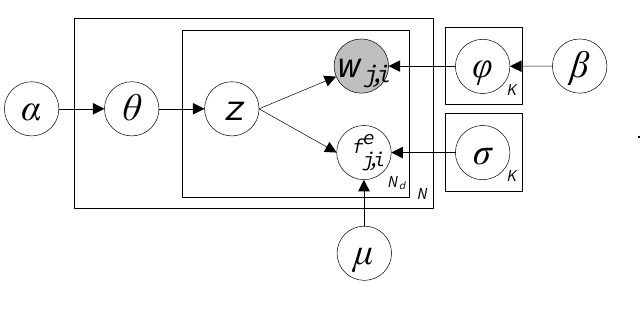
Fig 1. Plate notation of the EUMG model